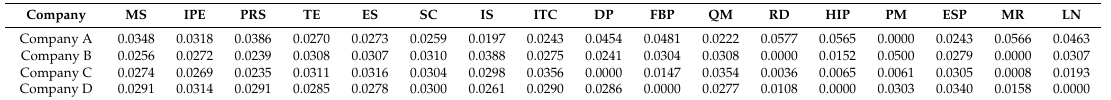
Table 6. Weighted normalization IAMS matrix.